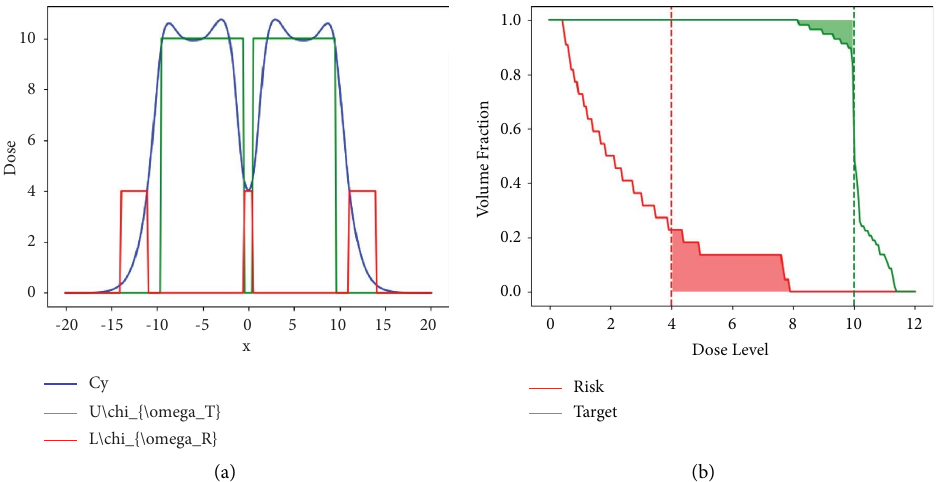
Figure 3: Dose information for dose-constrained equation (3) with 􏽥 β target level R . (b) Dose volume histogram for risk w R and target region w T .